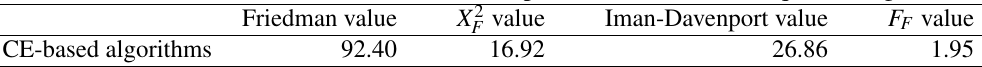
Figure 1: Rank distribution of CE-based algorithms considering all instances. As usual, each box comprises from the first to the third quartile of the distribution, the median (2nd quartile) is marked with a vertical line, whiskers span 1.5 times the inter-quartile range, and outliers are indicated with a plus sign. Table 2: Results of Friedman and Iman-Davenport tests for the techniques in Figure